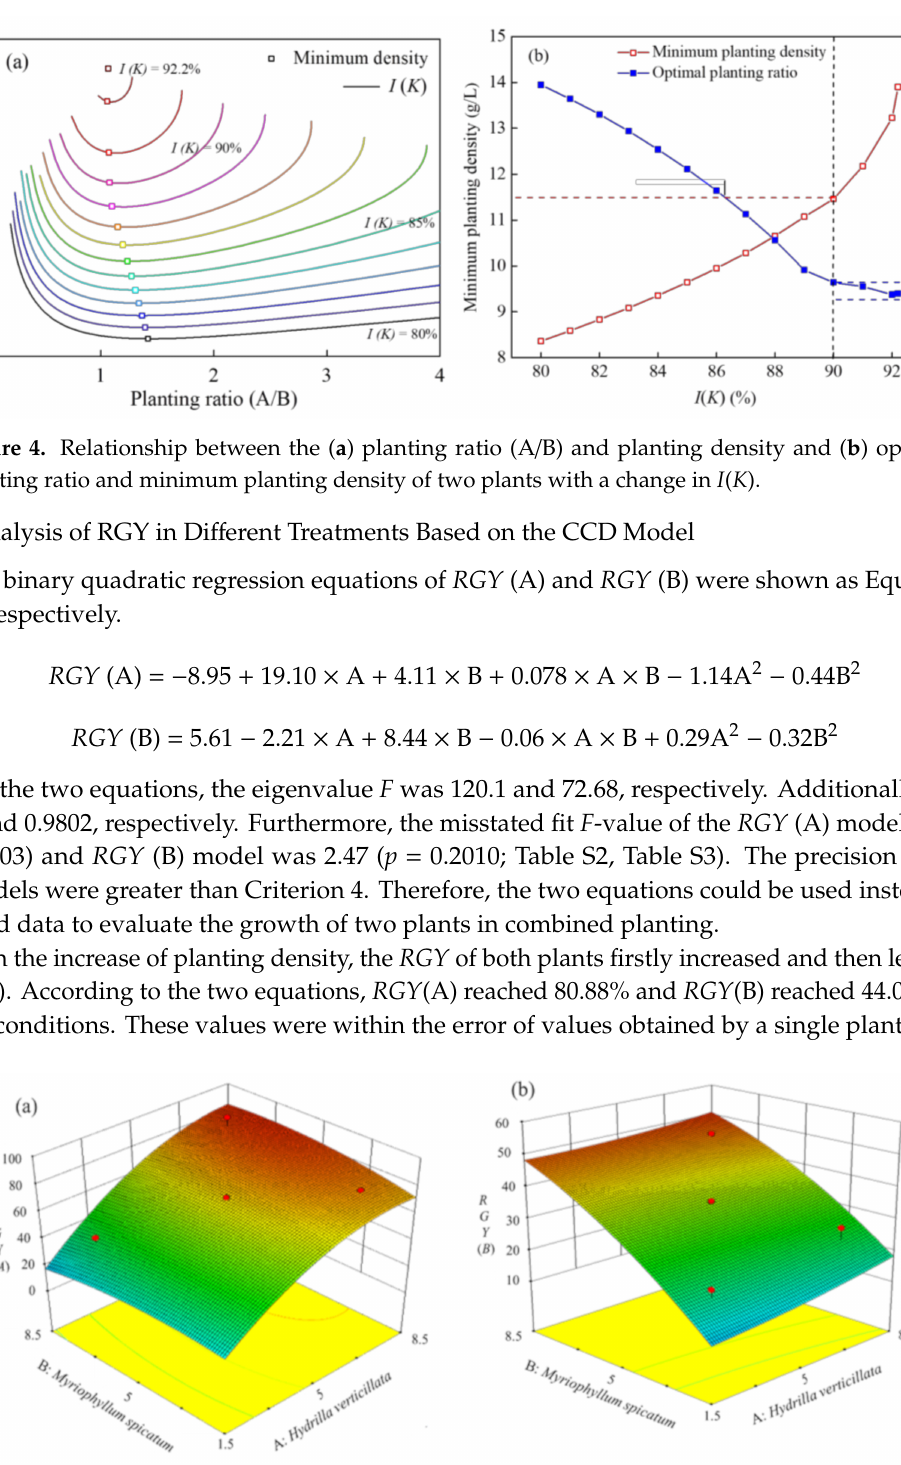
Figure 5. 3D surface plots showing interactions between the planting density of (A) H. verticillata and (B) M. spicatum with respect to the relative growth yield (RGY) (( a ) RGY (A) and ( b ) RGY